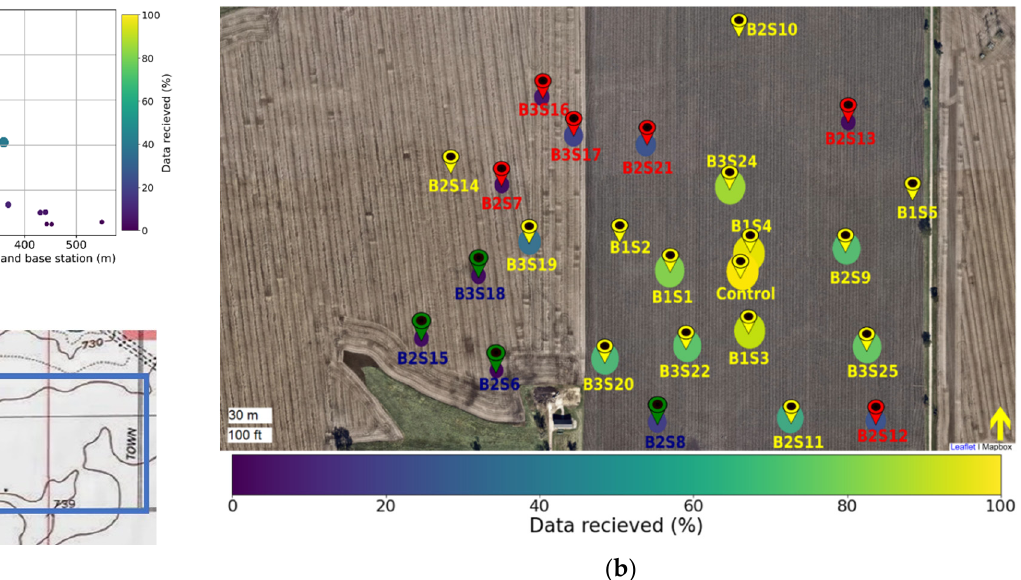
Figure 4. The average percentage of data packets received by the base station from the sensor nodes as a function of the horizontal distance from the base station ( a ) and from each sensor as they were located in the field ( b ). The size and color of the filled circles represents the percentage of data packets received. The flag indicates the base station location; yellow, red, and green pins represent sensors installed at 740 and 735 feet elevation and those installed in the flood plain zone of the study area, respectively ( b ). The soil topographic map ( c ) used to determine site elevation is retrieved from: https://www.usgs.gov/search-map?search=3DEP (accessed on 25 November 2020).